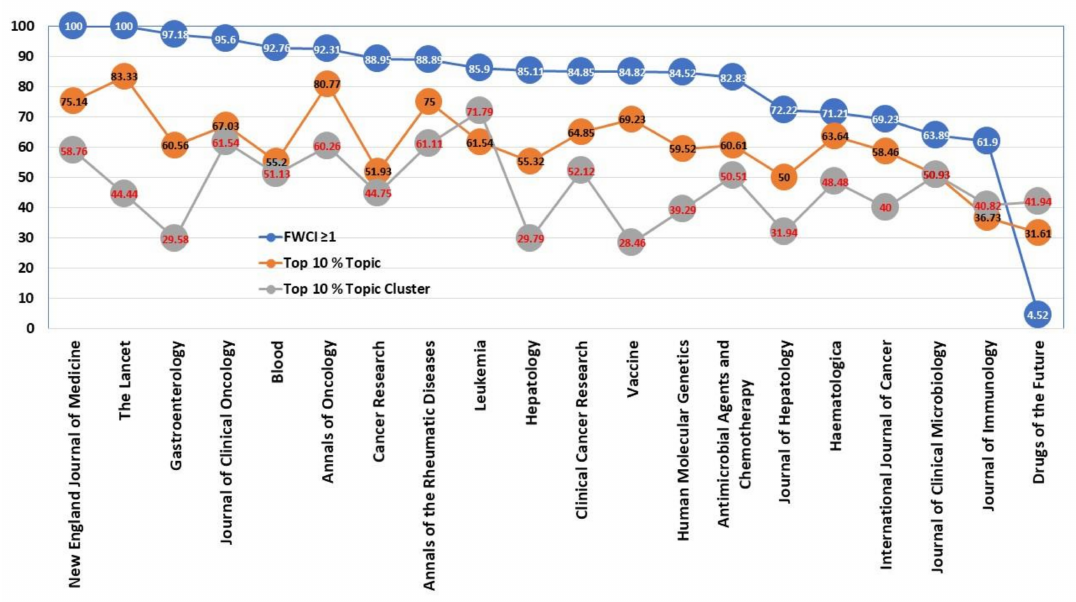
Figure 13. Percentage of articles at Topo 20 medicine journals: FWCI ≥ 1, Top 10% Topic and Topic